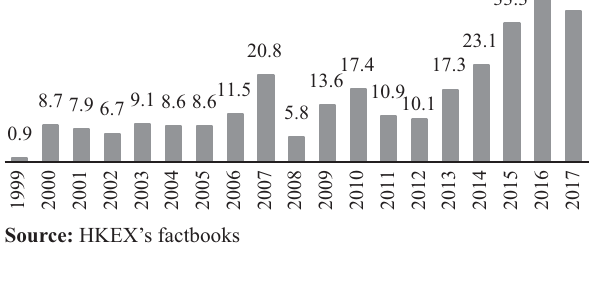
Figure 1. GEM ’ s market